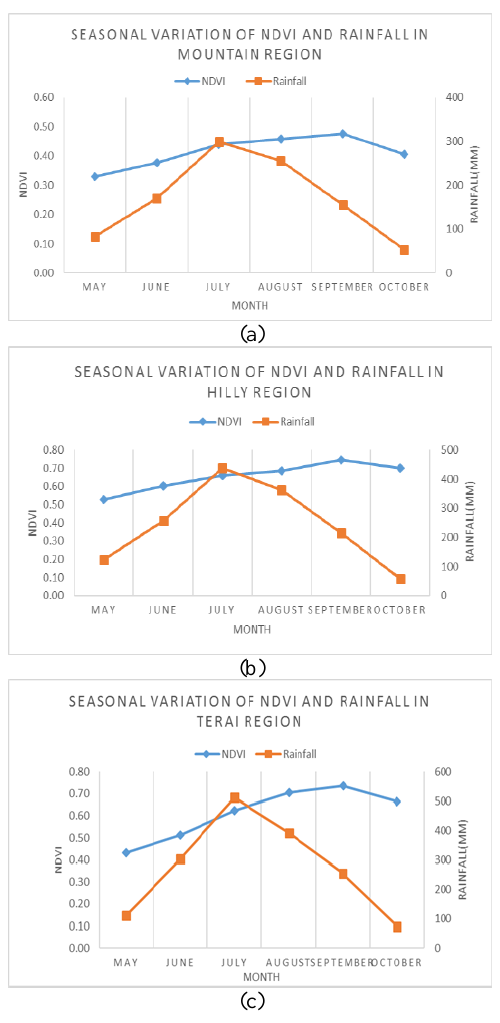
Figure 4 (a)-(c). Graph showing seasonal variation of NDVI with rainfall across (a). mountain, (b). hilly and (c). terai region